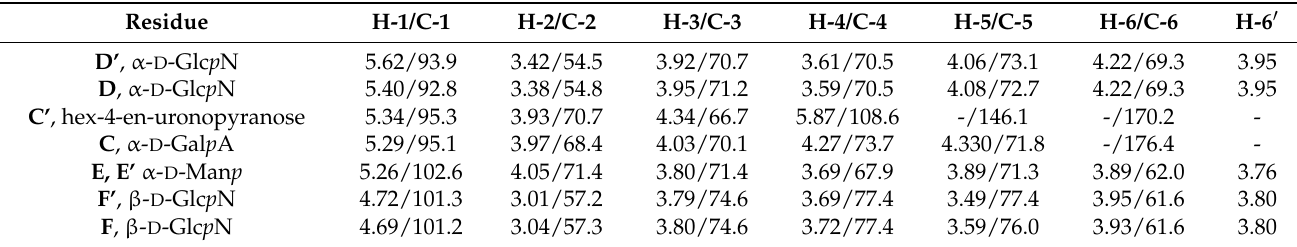
Table 4. 1 H and 13 C chemical shift data of the lipid A backbone tetrasaccharides α - D -Man p -(1 → 4)- β - D -Glc p N-(1 → 6)- α - enuronopyranose ( E’ → F’ → D’ → C’ ), obtained after mild hydrazinolysis and hot KOH treatment of lipid A from LPS of Rv . The spectra were recorded on a solution in 2 H 2 O at 27 ◦ C.